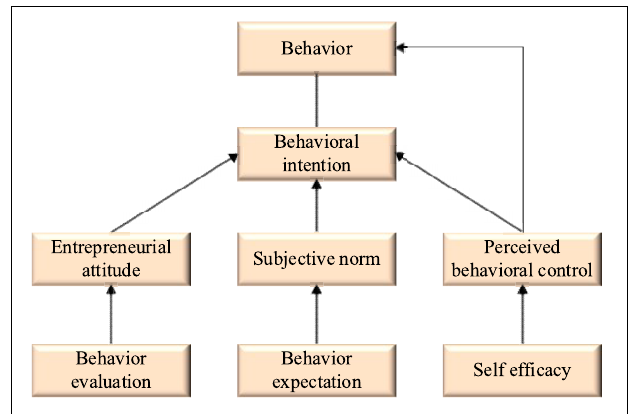
FIGURE 1 | Theoretical model of planned